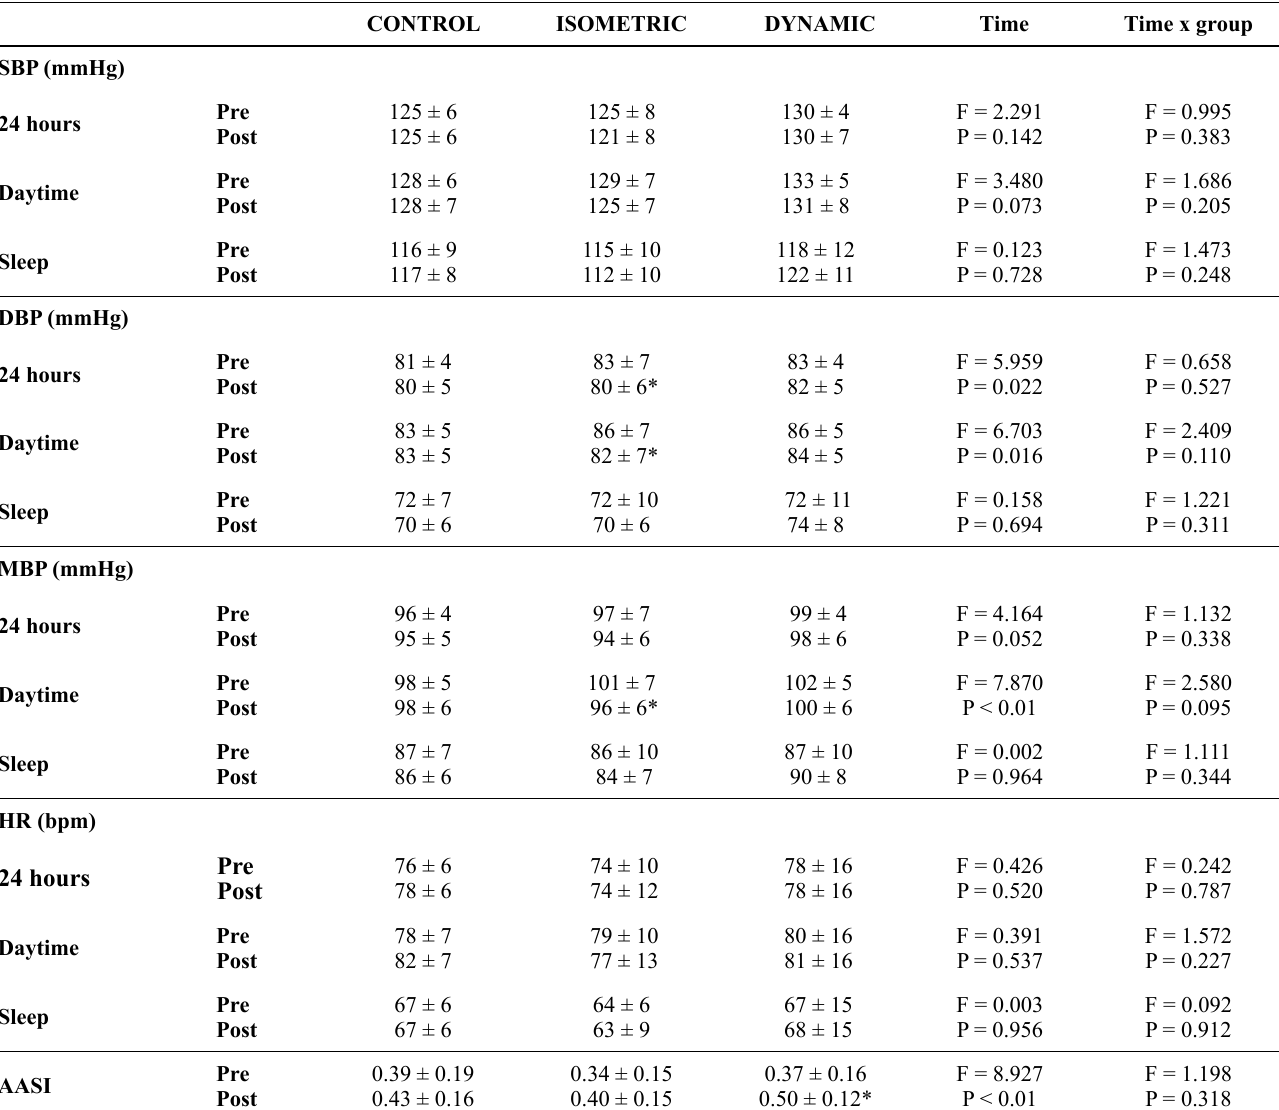
Table 2. Mean (±SD) of blood pressure, HR and AASI response according to the intervention and considering the different periods of the day. CONTROL ISOMETRIC DYNAMIC Time Time x